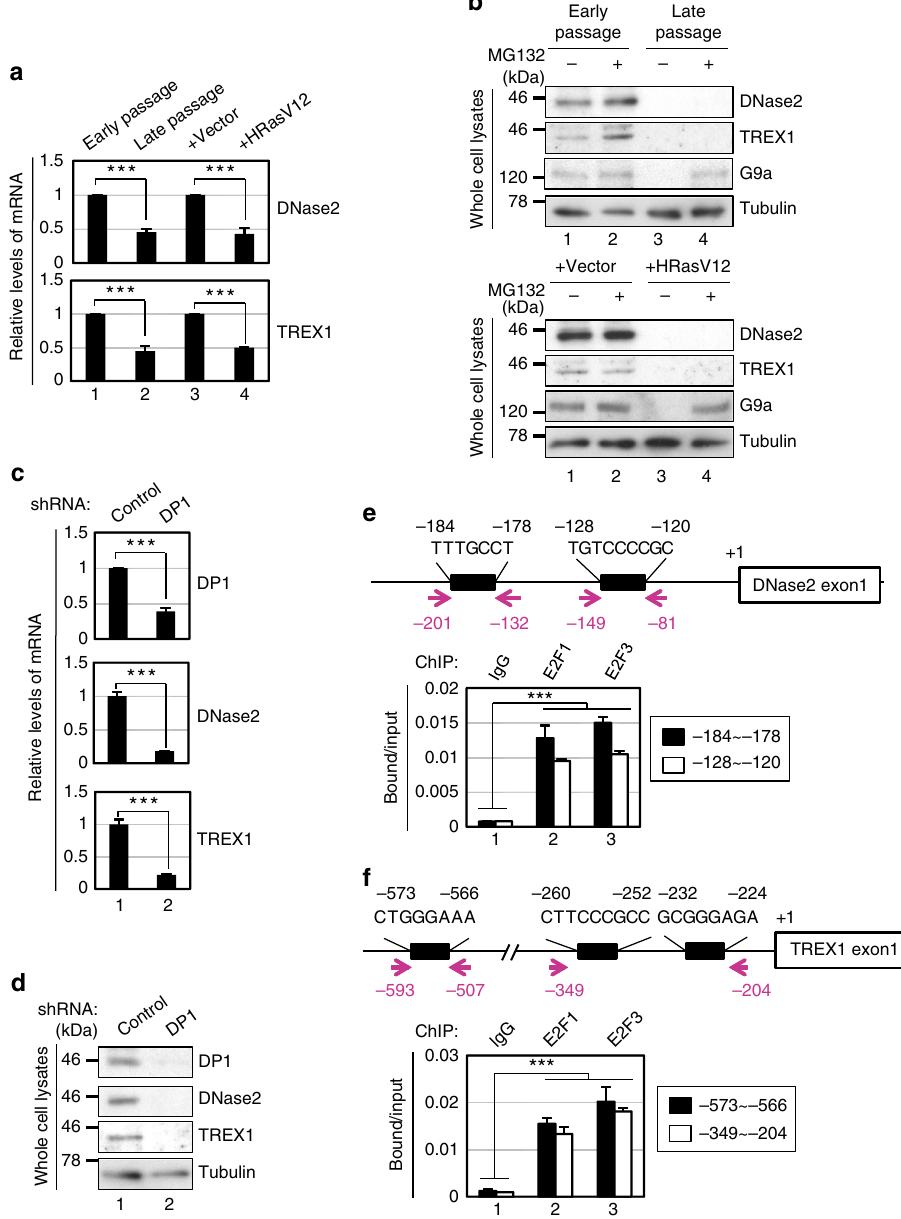
Fig. 5 E2F-dependent downregulation of DNase2 and TREX1 in senescent cells. a , b Pre-senescent TIG-3 cells were rendered senescent by either serial passage (late passage) or ectopic expression of oncogenic ras ( + HRasV12). These cells were then subjected to RT-qPCR analysis of DNase2 and TREX1 gene expressions ( a ), or incubated with 10 μ M MG132 for 12 h, then subjected to western blotting using antibodies shown right ( b ). c , d Pre-senescent TIG- 3 cells were infected with retrovirus encoding shRNA against DP1 or control three times. After puromycin selection, these cells were then subjected to RT- qPCR analysis of indicated genes shown right ( c ) or western blotting using antibodies shown right ( d ). Pre-senescent TIG-3 cells were subjected to ChIP analysis using antibodies shown at top and PCR primers of DNase2 promoter or TREX1 promoter shown as red arrows in the scheme ( e , f ). Tubulin was used as a loading control ( b , d ). The representative data from three independent experiments are shown. Error bars indicate mean ± standard deviation (s.d.) of triplicate measurements. (*** P < 0.001; one-way (Supplementary Fig. 6b) and the intracellular levels of ROS (Supplementary Fig. 6c). These results imply that a feedback loop may exist between the expression of cytoplasmic DNases and the STING pathway in HSCs. Taken together, these results strongly suggest that the downregulation of DNase2 and TREX1 expression and the consequent activation of the cytoplasmic DNA sensing pathway are likely to play key role(s) in the onset of